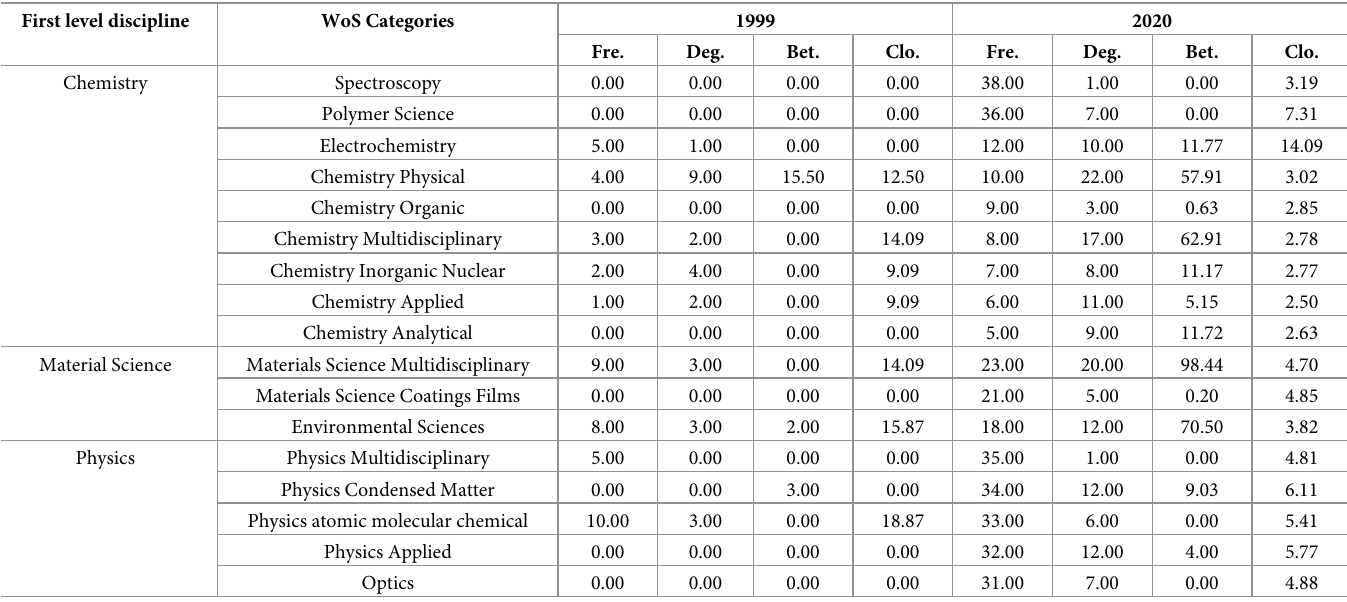
Table 4. The centrality of the main discipline in 1999 and